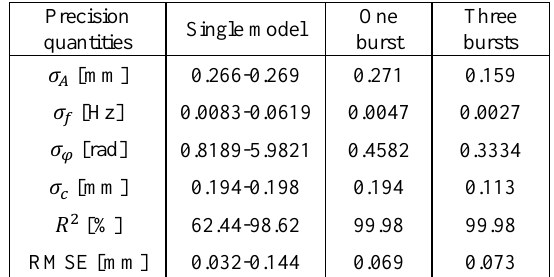
Table 6. Statistical values for the sinusoidal fitting parameters estimated for 𝑌 (3